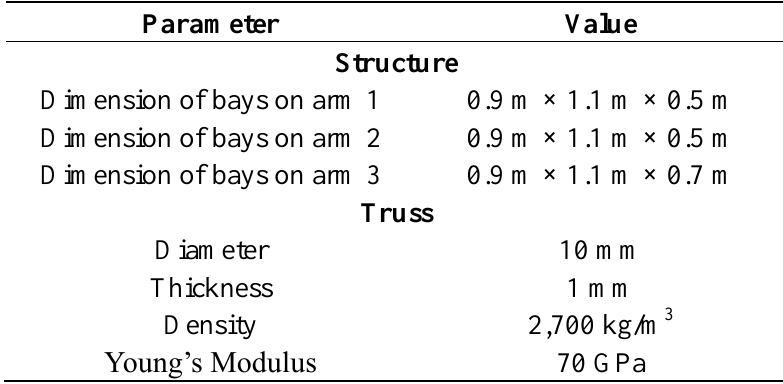
Table 1. Parameters of the space structure.